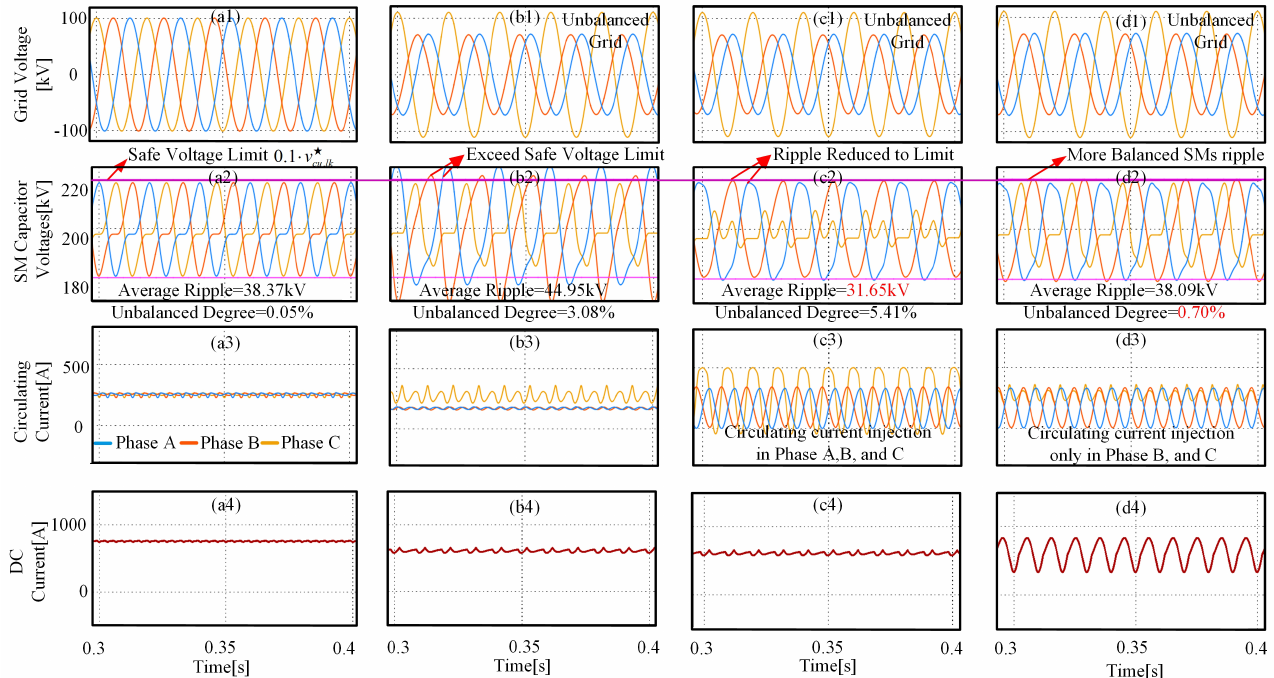
Figure 8. Simulation results. ( a ) balanced grid, ( a1 ) balanced grid voltages; ( a2 ) balanced SM ripple; ( a3 ) circulating current; ( a4 ) DC current. ( b ) unbalanced grid without circulating current injection. ( b1 ) unbalanced grid voltages; ( b2 ) unbalanced SM ripple; ( b3 ) circulating current; ( b4 ) DC current. ( c ) the results of Method A.( c1 ) unbalanced grid voltages; ( c2 ) SM ripple; ( c3 ) circulating current; ( c4 ) DC current. ( d ) the results of Method B. ( d1 ) unbalanced grid voltages; ( d2 ) SM ripple; ( d3 ) circulating current; ( d4 ) DC